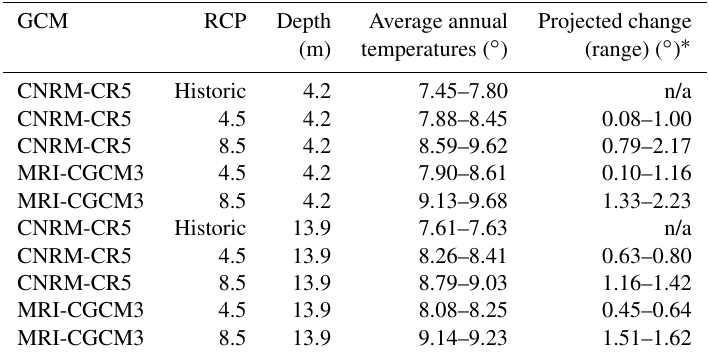
Table 2. Simulated groundwater temperatures for the future SHAW simulations at the two studied depths (4.2m is the piezometer sen- sor depth, while 13.9m is the depth from provincial monitoring well sensor; see text). GCM is the global circulation model; RCP is the Representative Concentration Pathway. n/a: not applicable. RCP